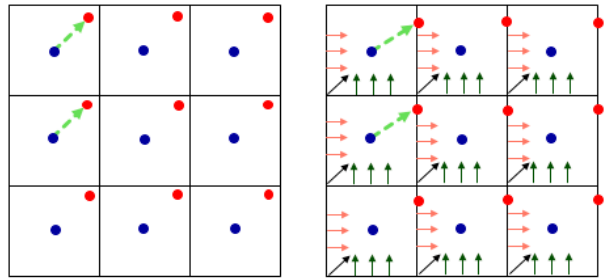
Figure 2. A translation on the square grid (by the vector represented by the broken arrow). The centers (blue points) represent the original gridpoints, while the red ones are the translated ones. On the right, it is also shown how to deal with points on the edges and on the corners. In the next subsection, some basics of the triangular grid will be recalled.